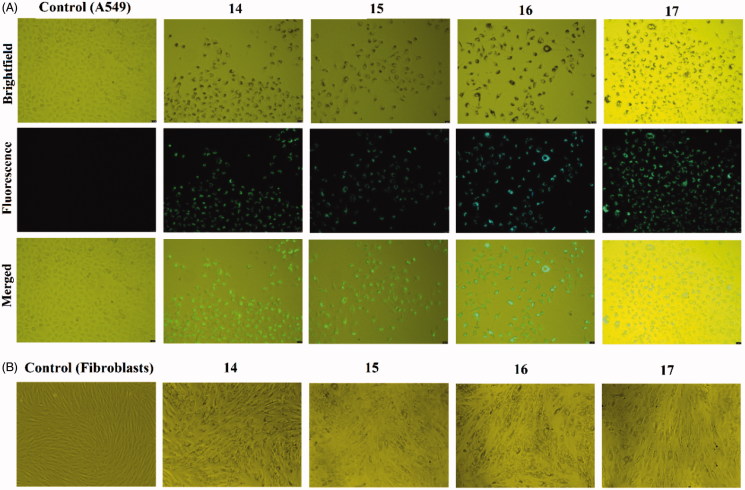
Intracellular accumulation after 24 h incubation of 14–17 in A549 cells (5 µM, A) visualized by fluorescence microscopy, and in fibroblasts (25 µM, B) visualized by phase contrast microscopy. Images were obtained by the fluorescence microscope Leica DMI6000B (HCX PL APO CS 10.0 × 0.40 DRY UV objective) and Leica DMI3000B. Presented images were obtained from three independent experiments.